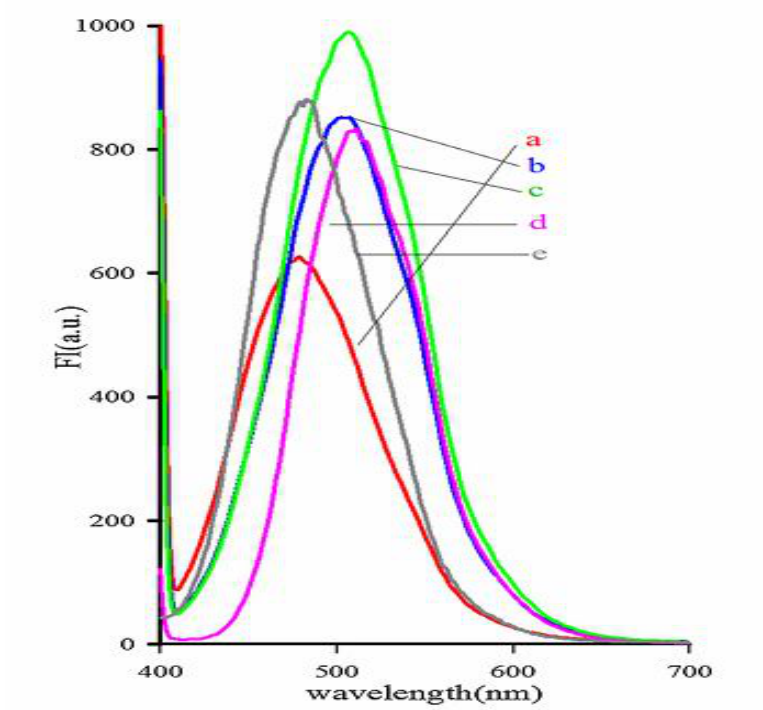
Fig. 4. Emission spectra excited at 377 nm of (a) SBA-SPS-Q, (b) SBA-SPS-QAl, (c) SBA-SPS-AlQ AlQ , and (e) SBA-SPS-Al(QS) 3